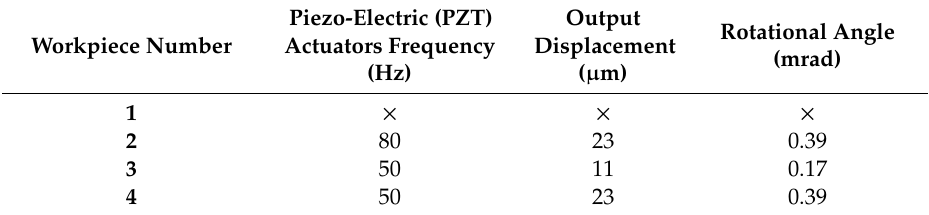
Table 4. The corresponding processing parameters of the 3D RVMS.